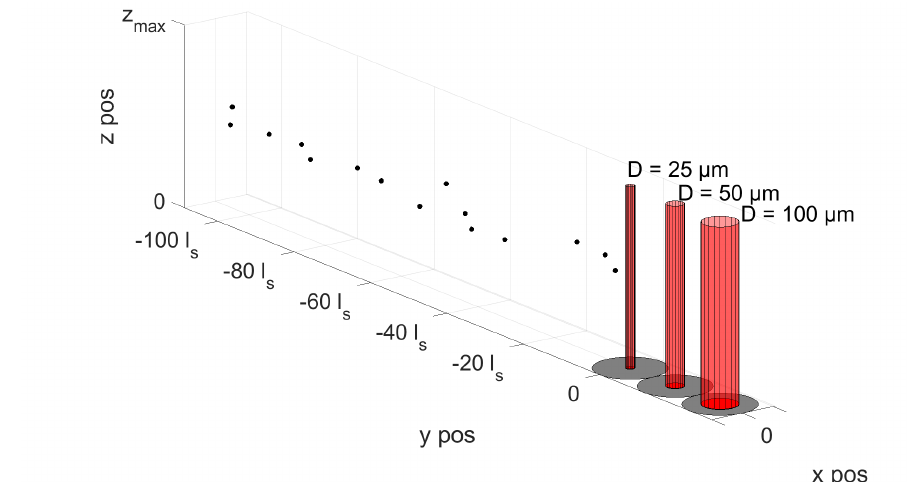
Figure 7. Particles are randomly distributed in the xy -plane (same z -value), and are moved in the positive y -direction with position steps equal to l s = v / f s . The black circles represent particles and the red cylinders constitute the three different sized apertures used in the